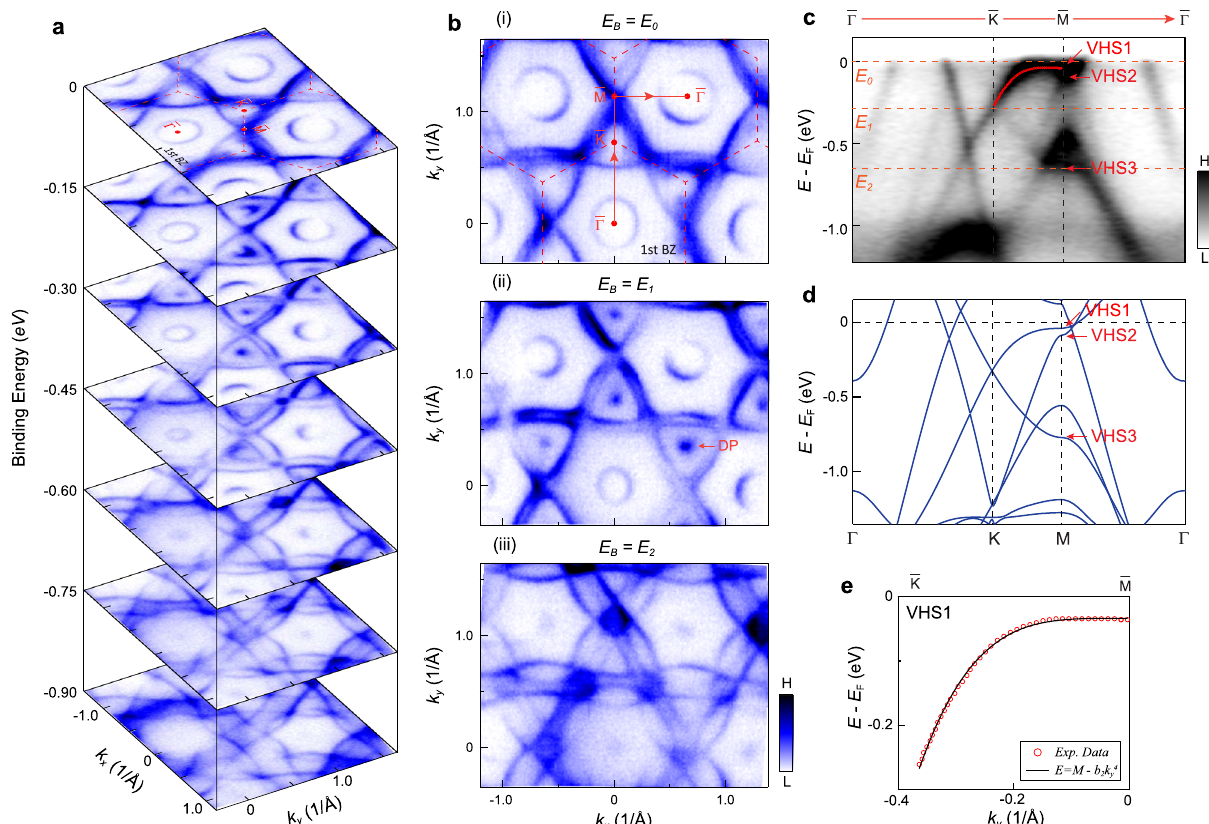
Fig. 2 Identi fi cation of multiple van Hove singularities in CsV 3 Sb 5 . a Stacking plots of constant energy contours at different binding energies ( E B ) showing sophisticated band structure evolution as a function of energy. b Fermi surface (i), constant energy contours (CEC) at E B of the Dirac point (DP) (ii), and CEC at the VHS3 (iii). c Experimental band dispersion along the (cid:1) Γ - (cid:1) K- (cid:1) M- (cid:1) Γ direction. The momentum direction is indicted by the red arrows in [ b (i)]. The orange dashed lines indicate the energy position of the Fermi level, Dirac cone and VHS3. d Calculated bands along the (cid:1) Γ - (cid:1) K- (cid:1) M- (cid:1) Γ direction. e Fittings of the k 4 measured dispersion along the (cid:1) M- (cid:1) K by E ¼ M (cid:2) b y form (the black line). The red dots represent the experimental data shown in ( c ) (see Supplementary 2 Fig. 3 for the details). The red arrows in ( c , d ) mark the multiple VHSs. All measurements were probed with circularly polarized light, at 200 K, and the (cid:1) Γ - (cid:1) M direction of the sample was aligned with the analyzer